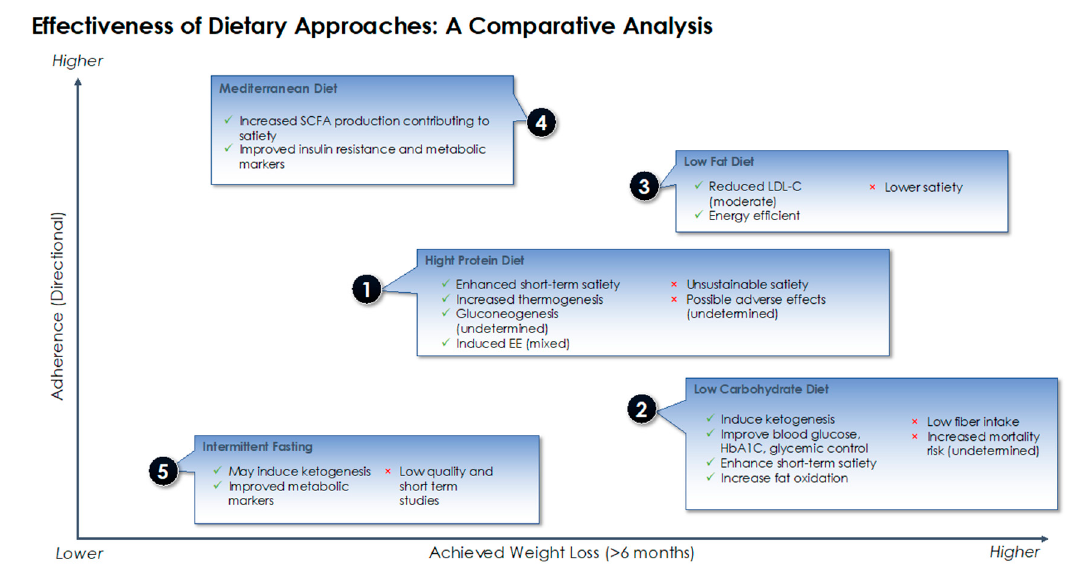
Figure 4. Comparative analysis of different dietary approaches in terms of weight loss, adherence and metabolic